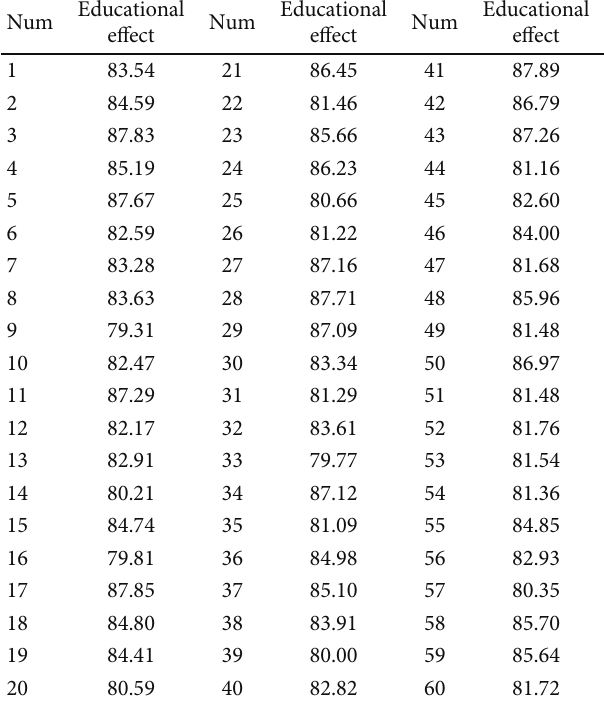
Table 1: Veri fi cation of the e ff ect of business English writing education system based on ternary interaction